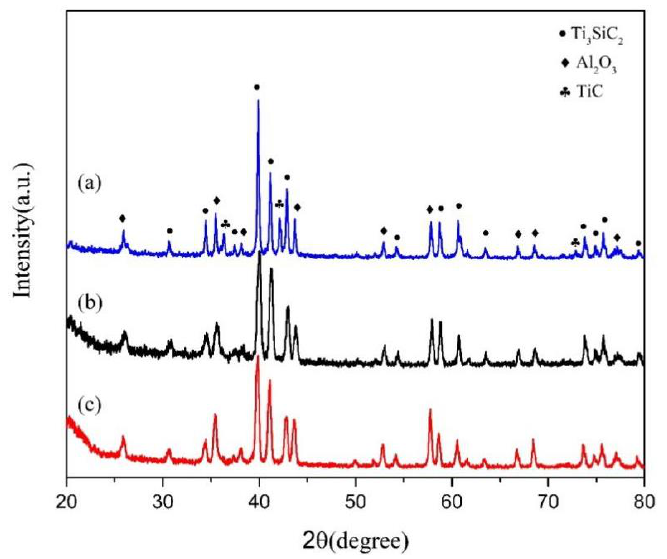
Figure 1. X-ray diffraction patterns of non-oxidizing materials: (a) TSC70, (b) TSC60 and (c) TSC50.